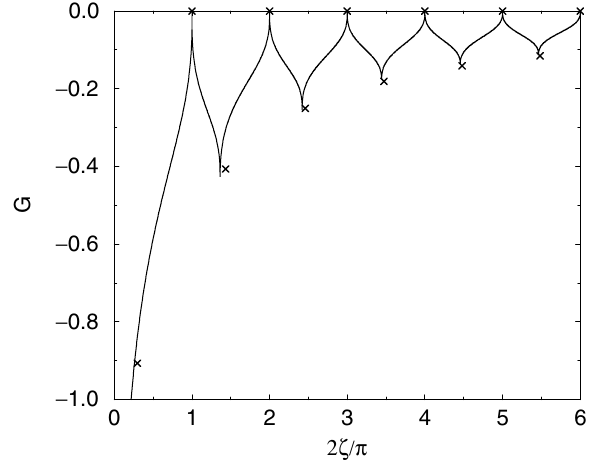
FIG. 1. The solid curve represents the G (cid:5) (cid:22) (cid:6) defined in Eq. (11) as a function of the normalized coordinate 2 (cid:22)=(cid:18) . The ( (cid:11) ) signs are the approximation given in Eq.